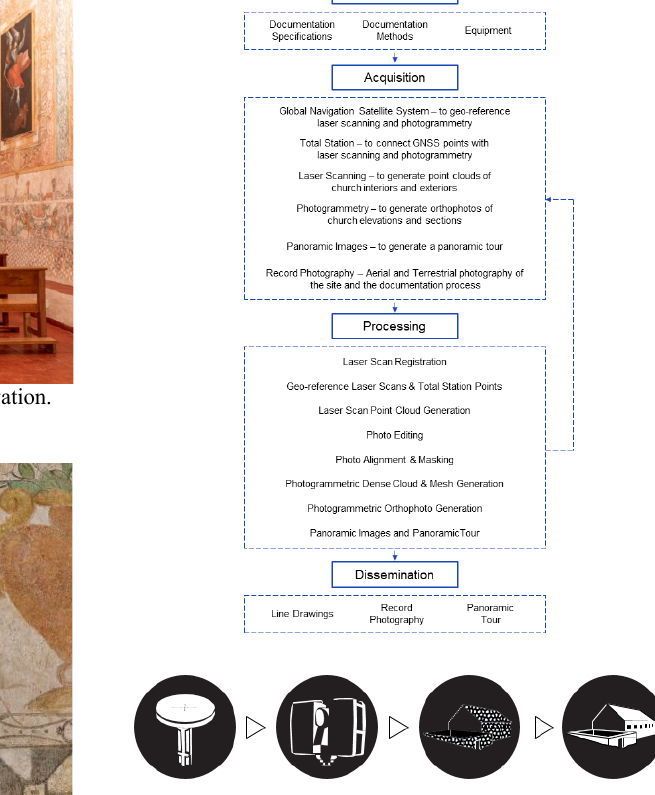
Figure 4 . Documentation project workflow (planning, acquisition, processing, dissemination). Diagram by CIMS © GCI